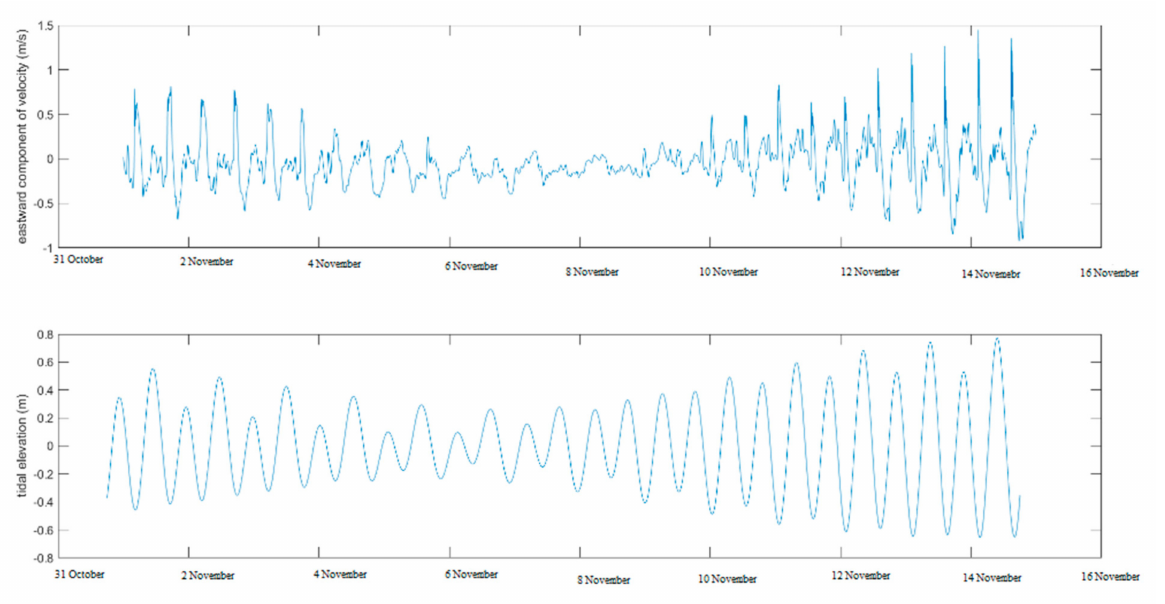
Figure 5. Eastward component of velocity at 125 m over the output location 100 km to the east of the generation ( top ) and low pass filtered sea level at generation location ( bottom ) for a small period in November